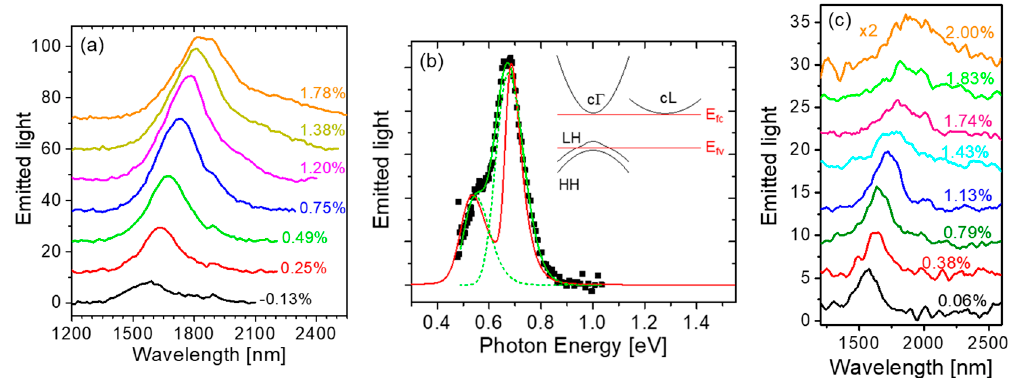
Figure 4. Strain-enhanced light emission from Ge NMs. ( a ) Room-temperature PL spectra of a 40-nm-thick undoped Ge NM at different levels of biaxial tensile strain; ( b ) Symbols: PL spectrum of the NM of (a) (normalized to the spectral response of the measurement setup) at a strain of 1.78%. Green lines: Gaussian fits showing the c Γ -HH and c Γ -LH contributions (dashed) and their sum (solid). Red line: calculated spontaneous emission spectrum. Inset: schematic band diagram of Ge at a strain of 1.78%, and estimated positions of the quasi-Fermi levels relative to the band edges in the presence of the PL pump pulses; ( c ) Room-temperature PL spectra of a 24-nm-thick undoped Ge NM at different levels of biaxial tensile strain. The vertical axes in ( a , c ) are in arbitrary units, and the different spectra are shifted vertically relative to one another for the sake of illustration clarity. The PL pump light in these measurements was provided by an optical parametric oscillator with 5-ns pulse width, 20-Hz repetition rate, 960-nm wavelength, and 3-mW average power. Reproduced with permission from [17]. National Academy of Sciences, 2011.